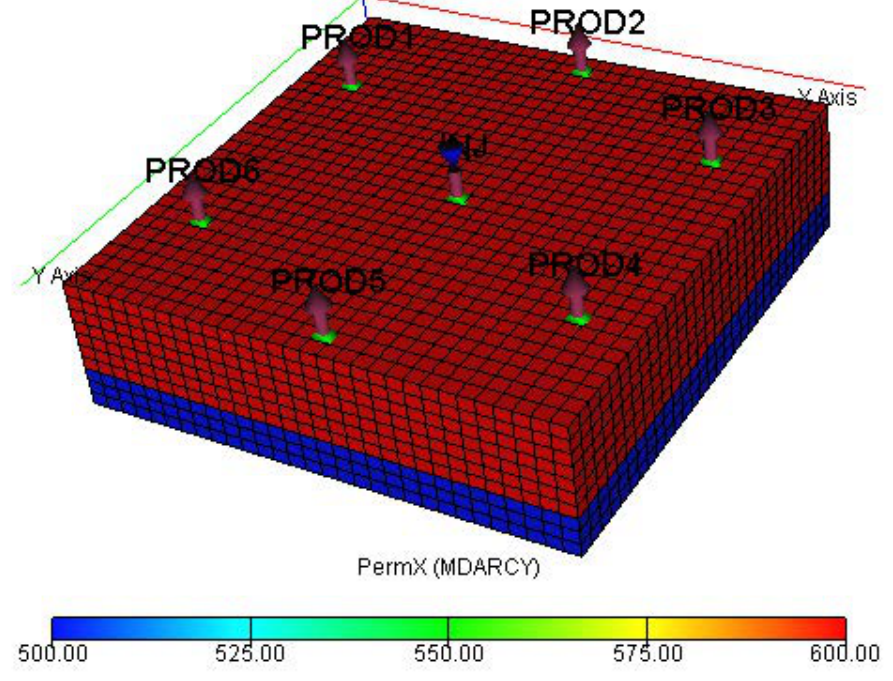
Figure 6. Permeability